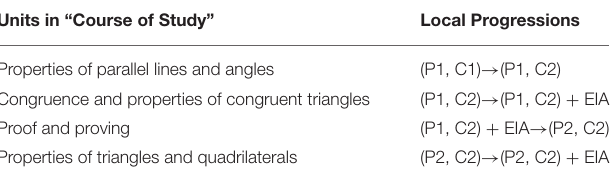
TABLE 1 | Correspondence of intended units with local progressions in Grade 8